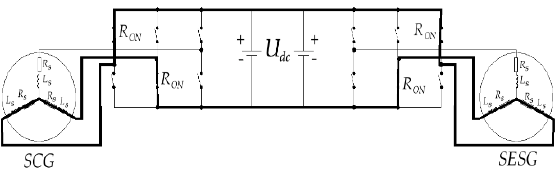
Fig. 2. Path of circulating current flowing through transistors (R ON ) of synchronous (SESG) and asynchronous squirrel-cage (SCG) converters